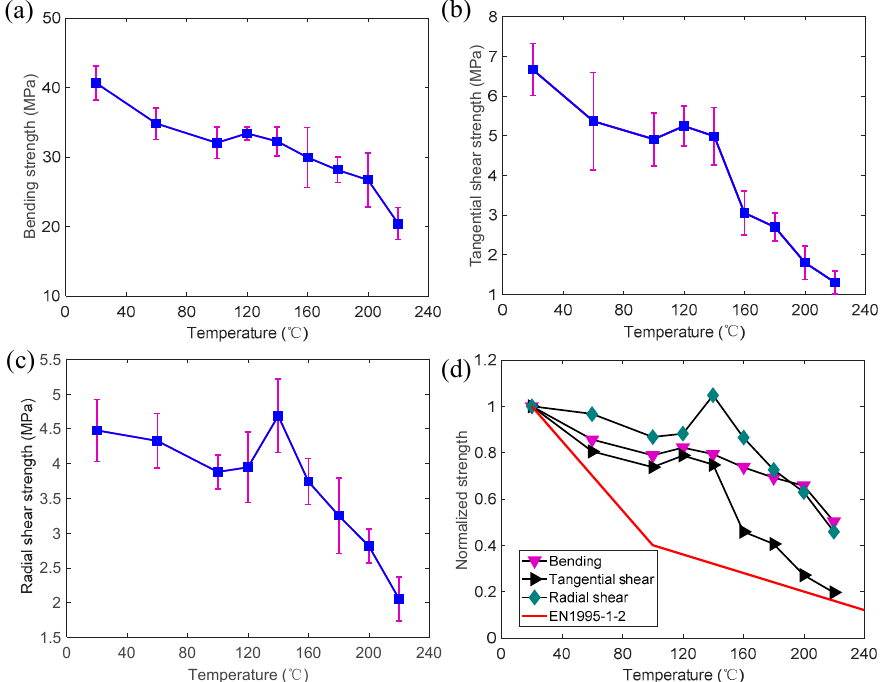
Figure 10. Temperature-dependent strength progressions with standard deviations (purple line): ( a ) bending; ( b ) tangential shear; ( c ) radial shear; ( d ) normalized value.